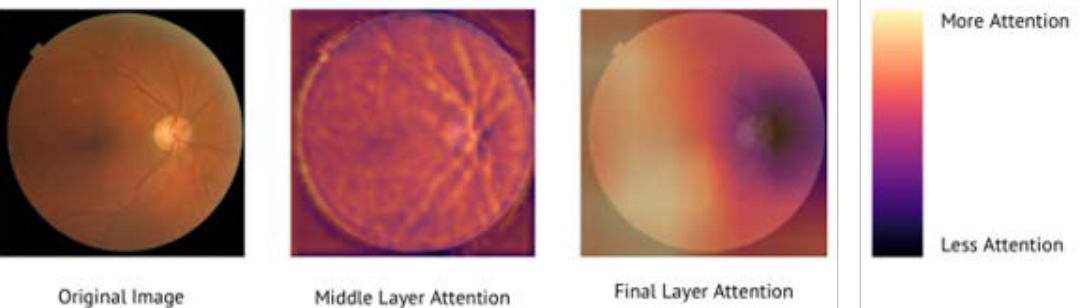
Figure 6. Gradient activation map. This map demonstrates which region of the image the AI model is attending to at various CNN layer depths. The original fundus image for analysis is on the far left. The second image demonstrates which areas of the image the model is paying the greatest attention to in the middle layers of the model. The third image demonstrates the regions of the fundus image that the final layer of the model is paying most attention towards. The scale on the far right indicates the per-pixel degree of model attention from most attention to least attention.